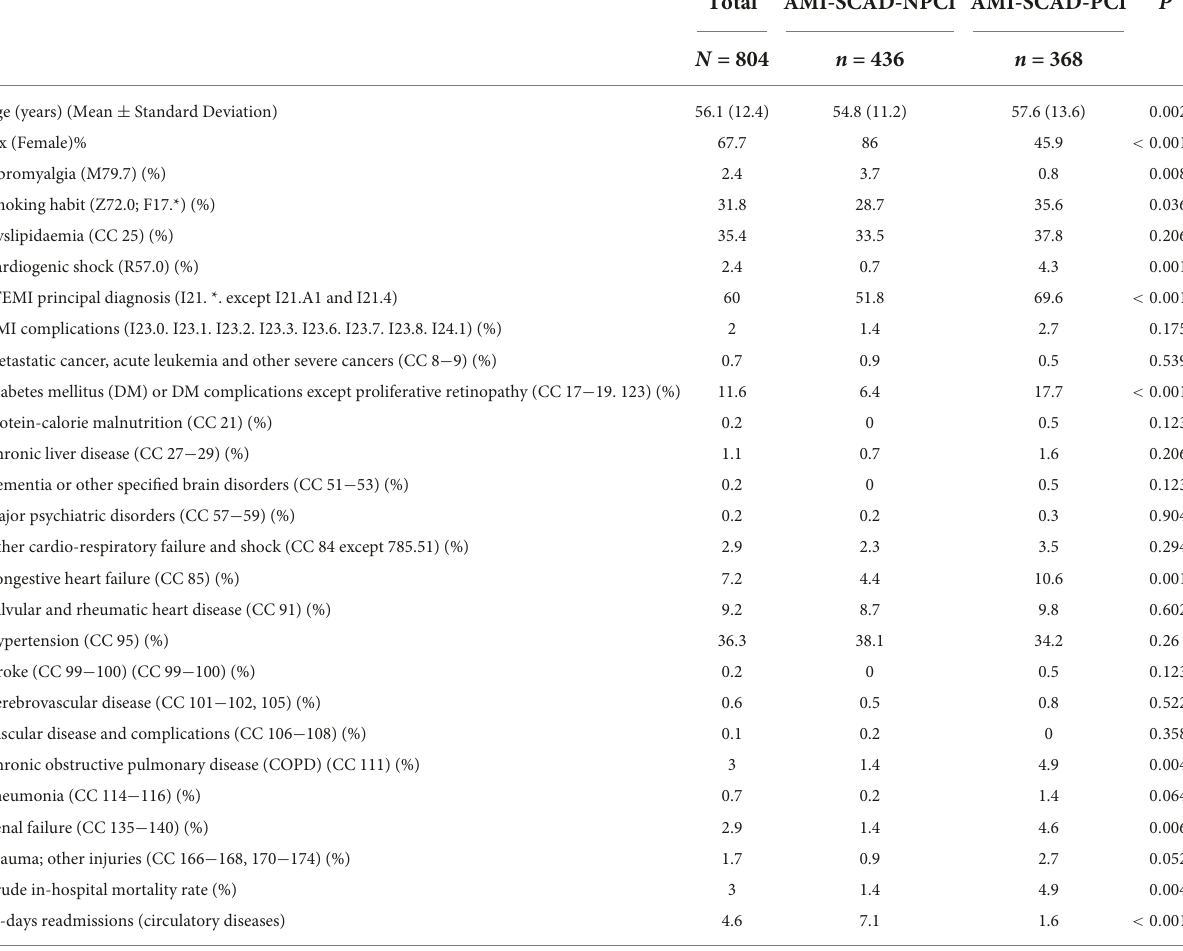
TABLE 1 Differences between patients with spontaneous coronary artery dissection and acute myocardial infarction treated with and without percutaenous coronary intervention.